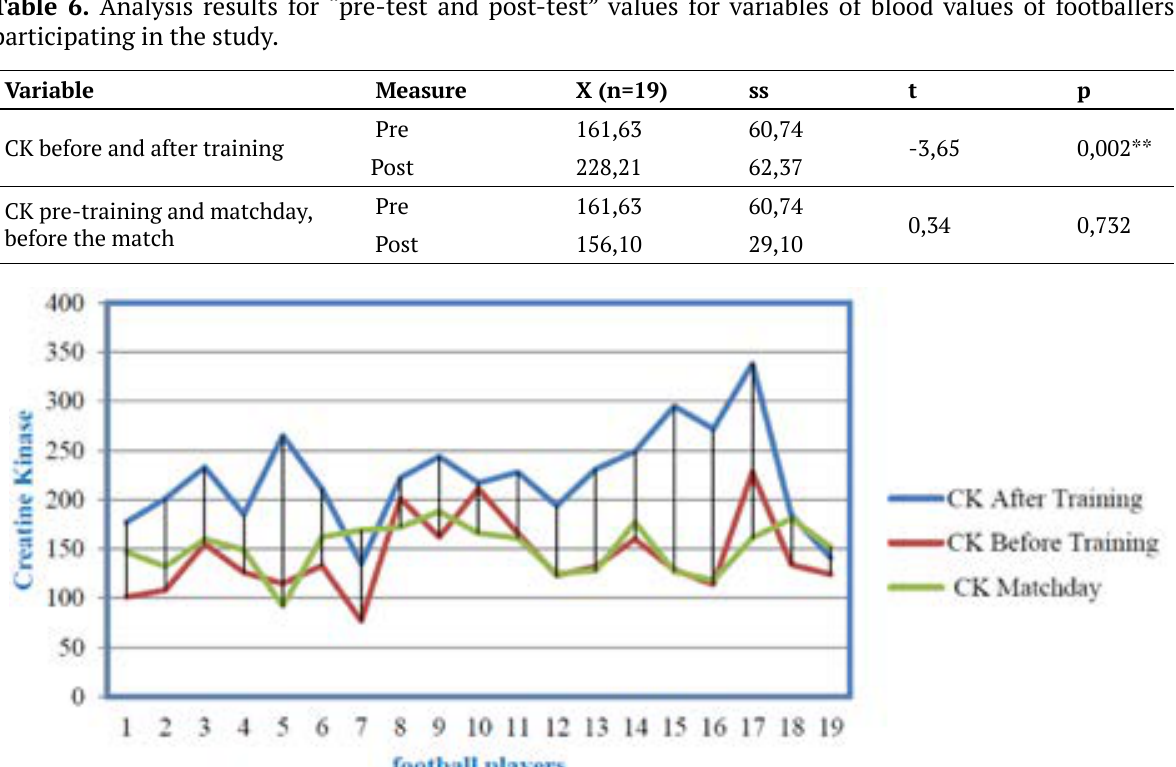
Figure1. Creatine kinase (CK) values of the players before training, after training and match day